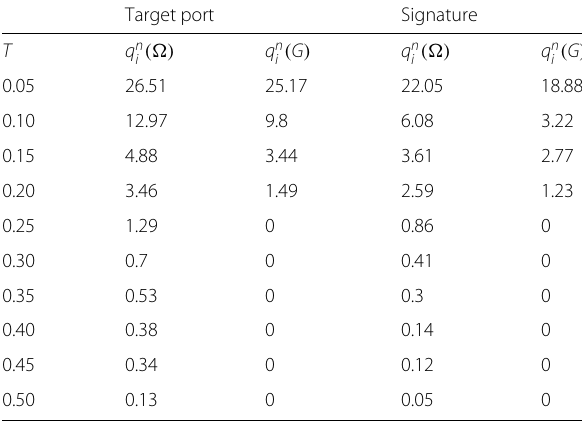
Table 3 The percentage of times q n the target port and alert signature